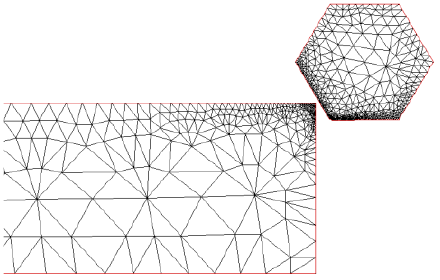
Figure 5. Two-dimensional model of the diamond grit.